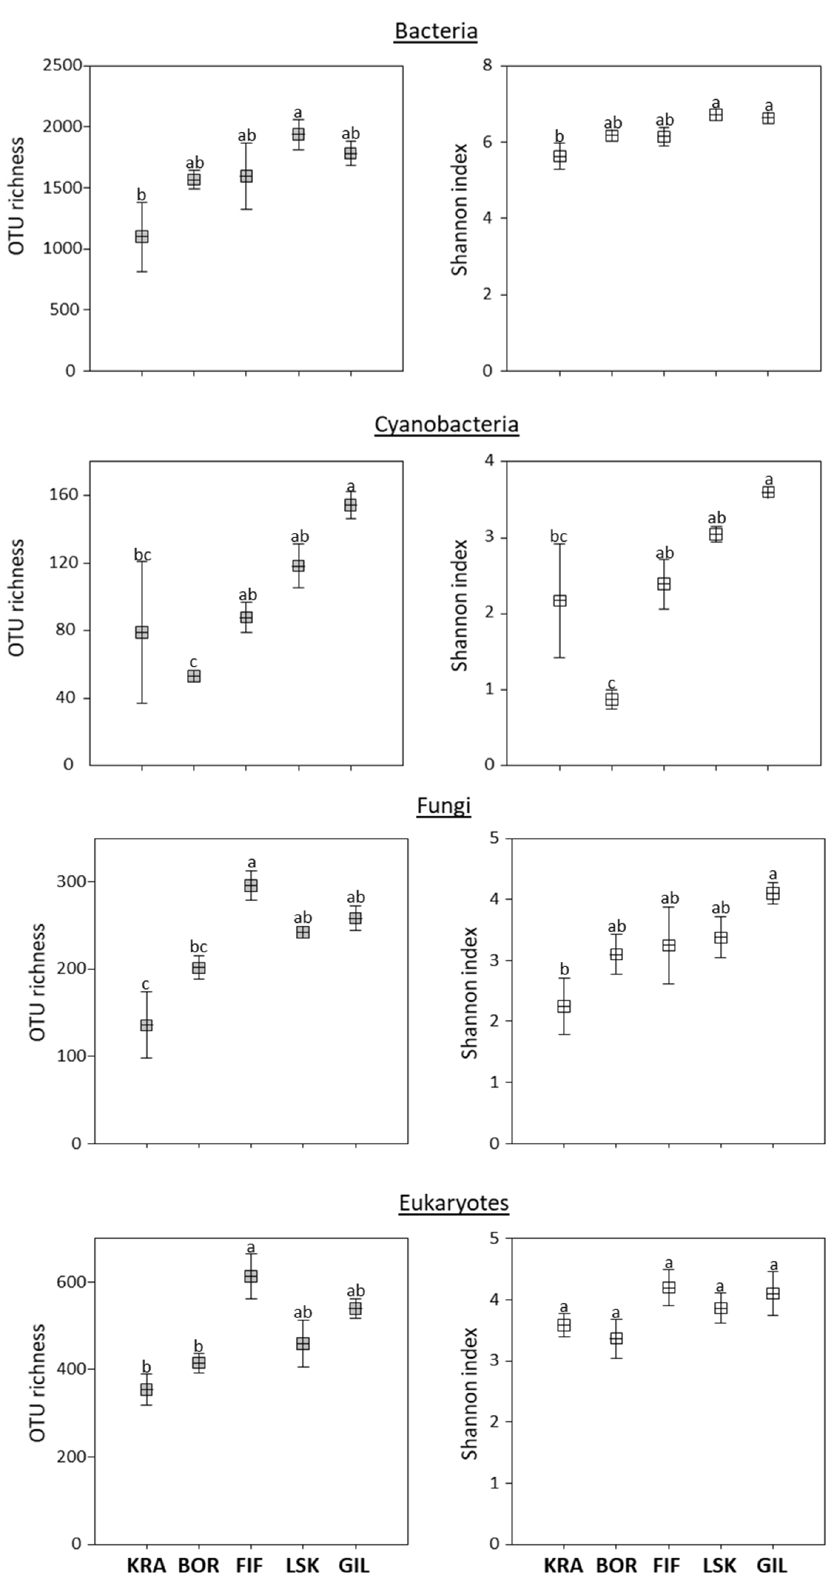
Figure 3. OTU richness and Shannon index in Icelandic biocrusts. The sites are listed in order of elevation gradient from 11 to 157 m a.s.l., respectively. KRA—Krákunes, BOR—Borgarfjarðarbraut, FIF—Fiflholt, LSK—Litla-Skard, and GIL—Giljar. Same letters indicate no statistical difference between the samples according to one-way ANOVA followed by Tukey HSD post hoc test.